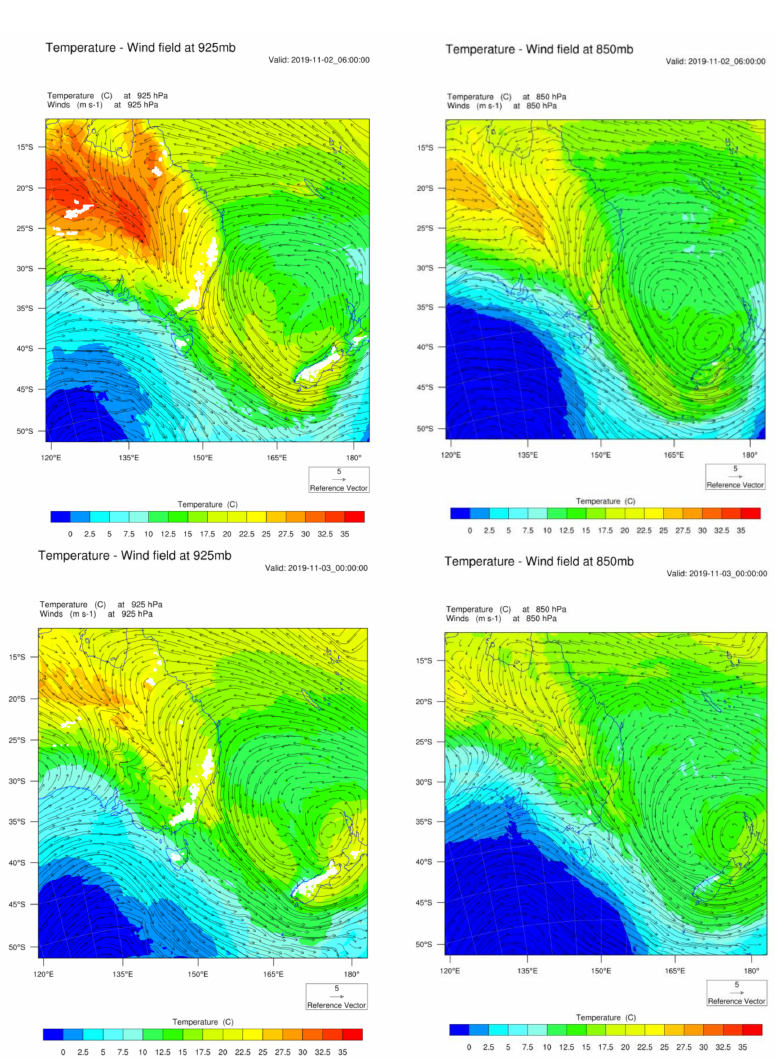
Figure A1. Predicted wind and temperature at 925 mb and 850 mb on 2 November 2019, 06:00 UTC, and 3 November 2019, 00:00 UTC.